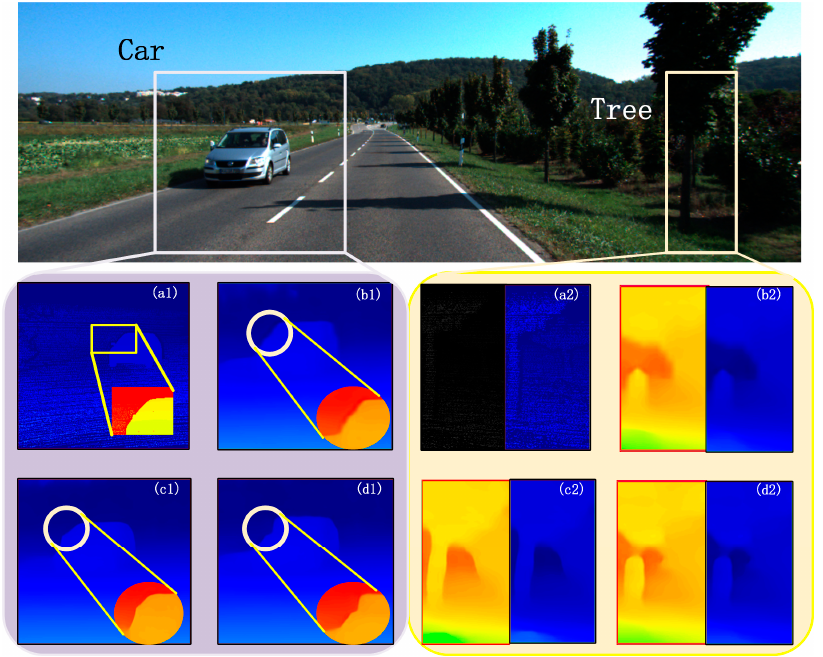
Figure 8. The rendering of the multi-level cost volume ablation experiment on KITTI2015. ( a1 ) and ( a2 ) are the ground truth, ( b1 ) and ( b2 ) are the result of the prediction of cost volume constructed in 32 dimensions, and ( c1 ) and ( c2 ) are in 96 dimensions, ( d1 ) and ( d2 ) are in 128 dimensions. As you can see, for the car in the left box, the shape in ( b1 ) and ( d1 ) is not fitting, and the car in ( c1 ) is the similar shape. For the trunk in the right box, there are still unclear edges and target truncations in ( b2 ) and( d2 ), the shape that best fits the true depth image in ( c2 ).